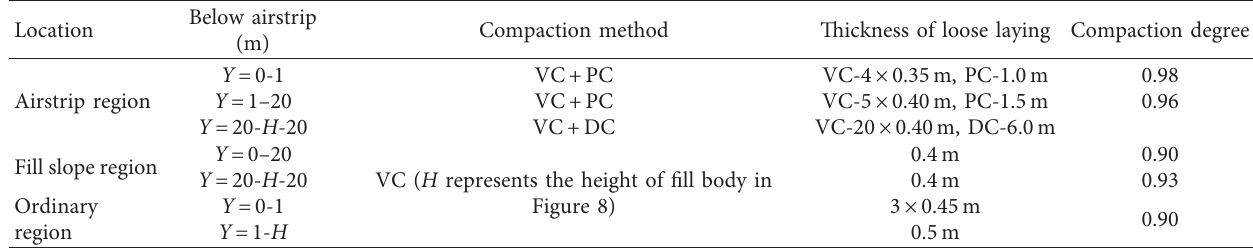
Figure 9: Compaction degree design of fill material in the test section. Table 6: Compaction methods and compaction degree standards of test